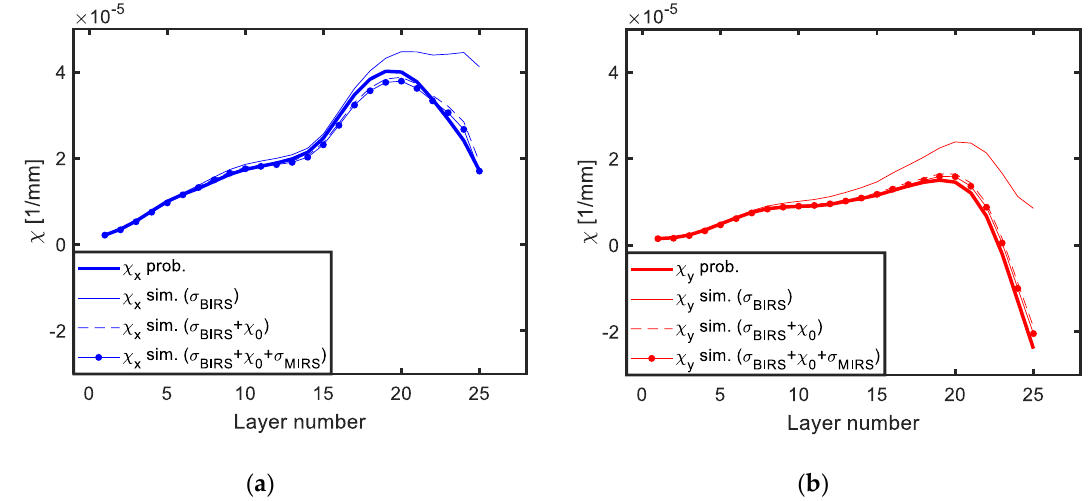
Figure 10. Experimental vs. simulated curvatures for the LR process of a machining plate with known BIRS profile (measured by on-machine layer removal method): X direction ( a ) and Y direction ( b ).